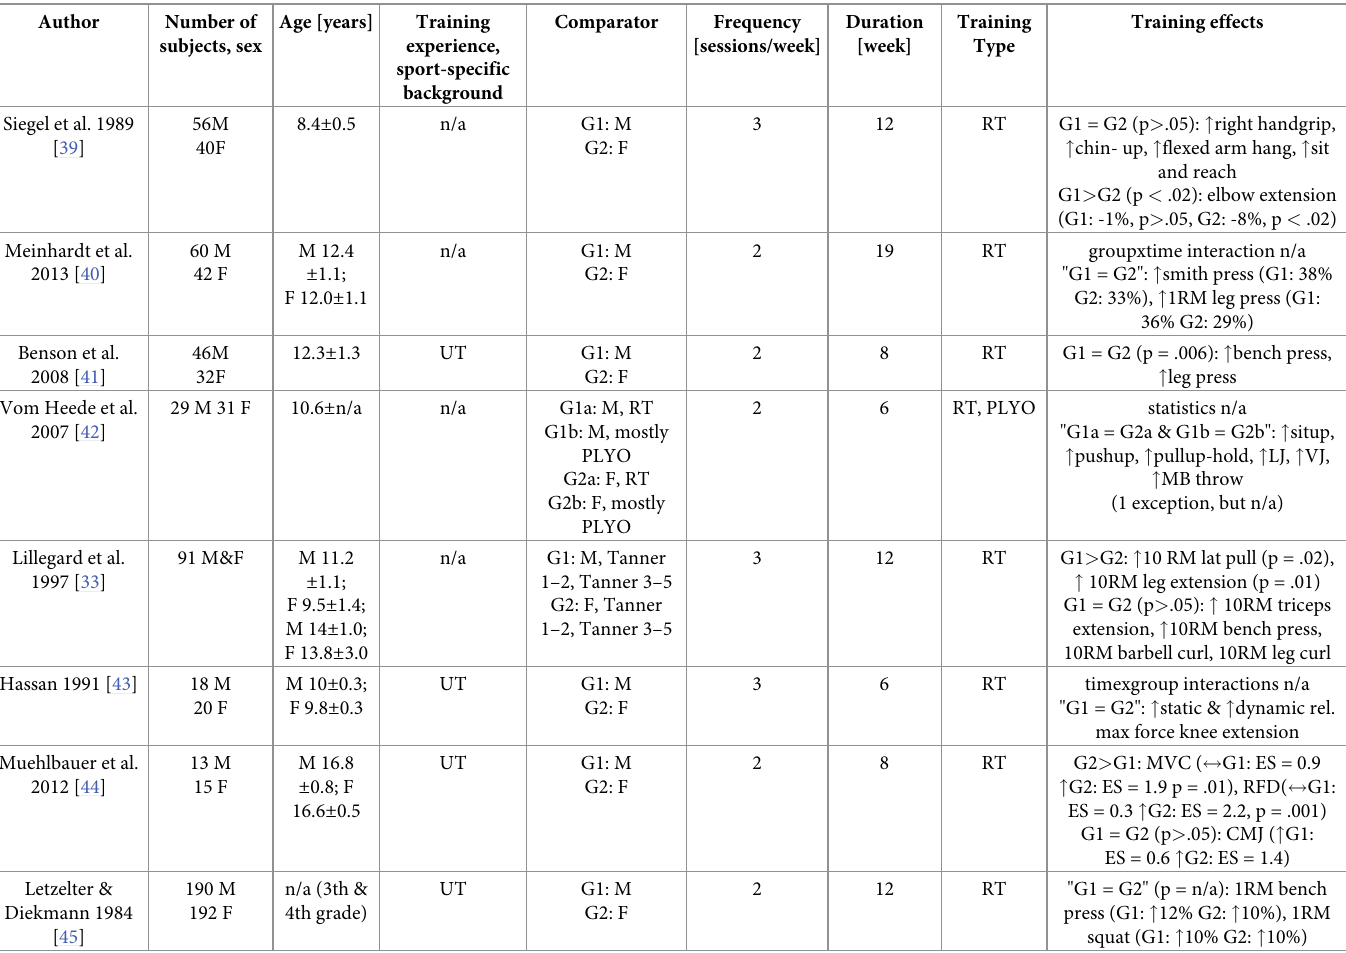
Table 2. Influence of the moderating variable ‘sex’ on resistance training induced improvements in components of physical